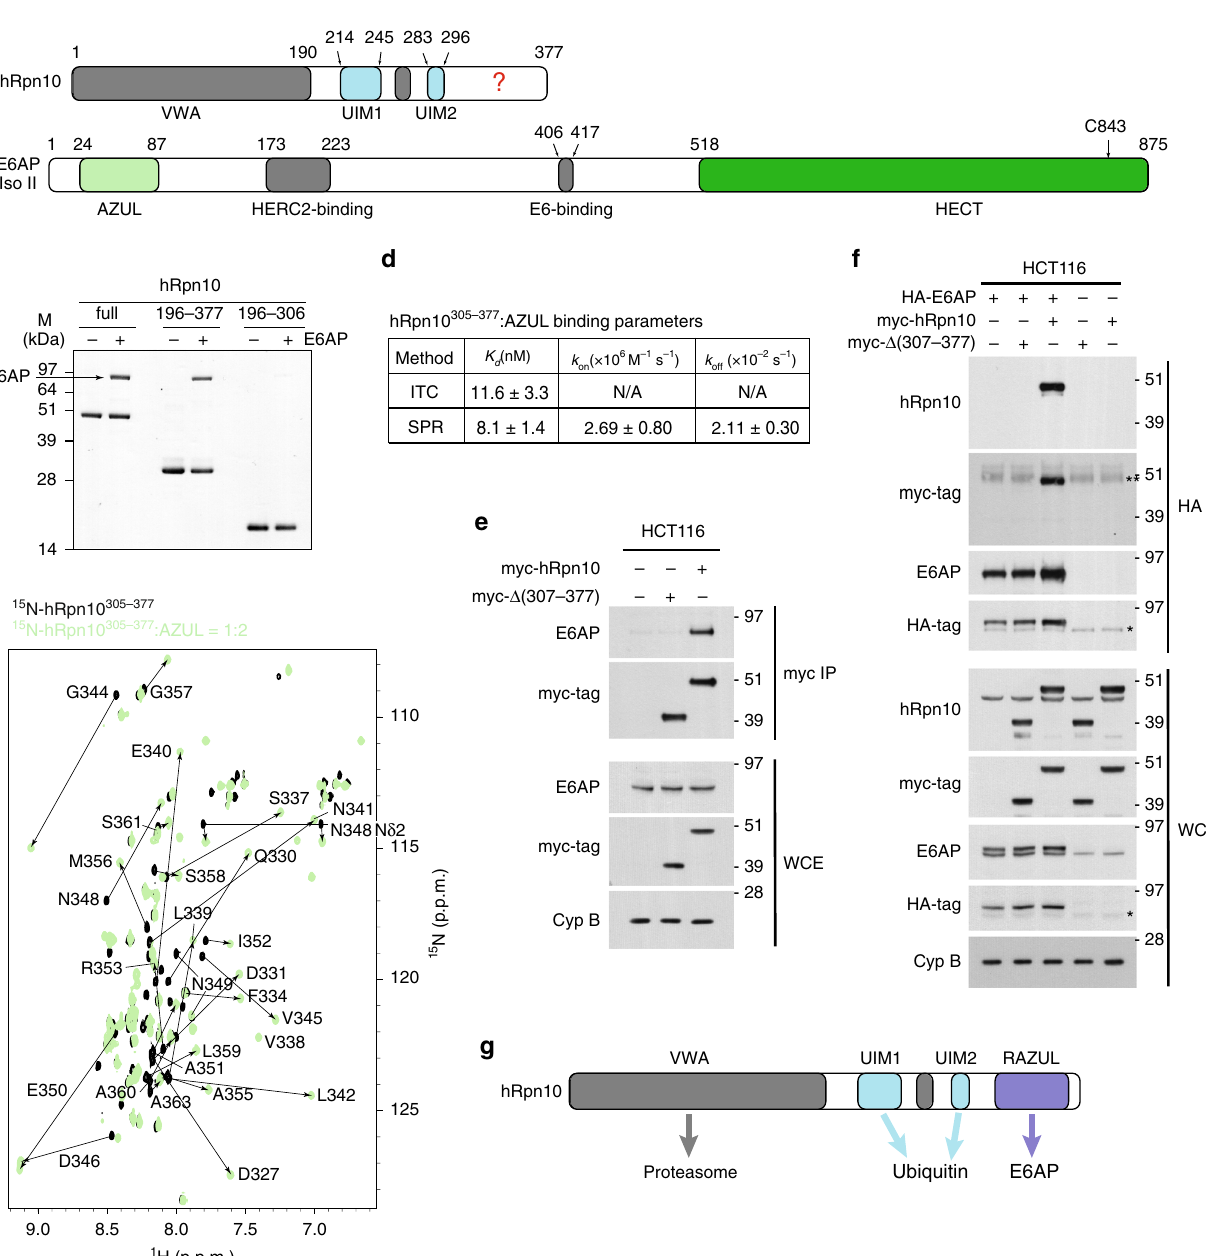
Fig. 1 A C-terminal domain in hRpn10 binds E6AP AZUL. a Positions of known functional domains within hRpn10 (top) and E6AP isoform II (bottom). Question mark “ ? ” indicates hRpn10 uncharacterized region and the E6AP catalytic cysteine C843 is indicated. b Pull-down assay of His-tagged hRpn10 full-length (full), hRpn10 196 – 377 or hRpn10 196 – 306 without ( − ) or with ( + ) incubation of E6AP. c 1 H, 15 N HSQC spectra of 0.2mM 15 N-hRpn10 305 – 377 (black) and with twofold molar excess unlabeled AZUL (green). Shifted signals are labeled. d Table summarizing K d , k on , and k off average values with standard deviations for the hRpn10 305 – 377 : AZUL interaction measured by ITC and/or SPR. N/A, not applicable. e HCT116 lysates expressing empty vector, myc-hRpn10 full length, or myc- Rpn10 with RAZUL deleted ( Δ 307 – 377) were subjected to myc-immunoprecipitation with anti-myc-tag nanobody-coupled agarose. Whole cell extracts (WCE) and myc-immunoprecipitates were immunoprobed with the indicated antibodies. Cyclophilin B (Cyp B) is used as a loading control in e and f . f Lysates from HCT116 cells expressing HA-E6AP and the myc-hRpn10 constructs of e were subjected to HA IP followed by immunoblotting with the indicated antibodies. An asterisk “ * ” indicates non-speci fi c interaction; double asterisk “ ** ” indicates heavy chain antibody. e – f All antibodies used for immunoprobing are indicated to the left of the images. Note that the hRpn10 and E6AP antibodies recognize both endogenous and exogenously expressed protein, causing these panels to show both tagged and endogenous protein. g Schematic representation highlighting interaction domains of hRpn10 including newly identi fi ed RAZUL. Source data are provided as a Source Data fi